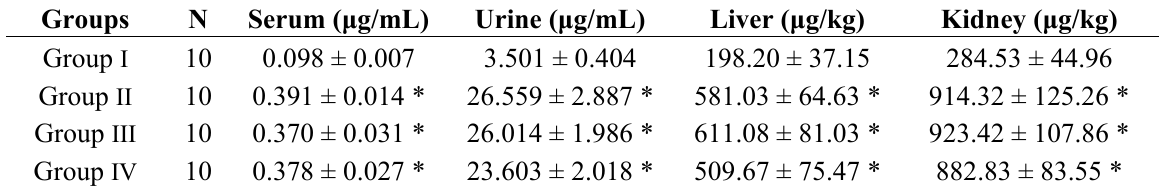
Table 1. The levels of fluoride in serum, urine, liver and kidney of rats (X ± SEM).